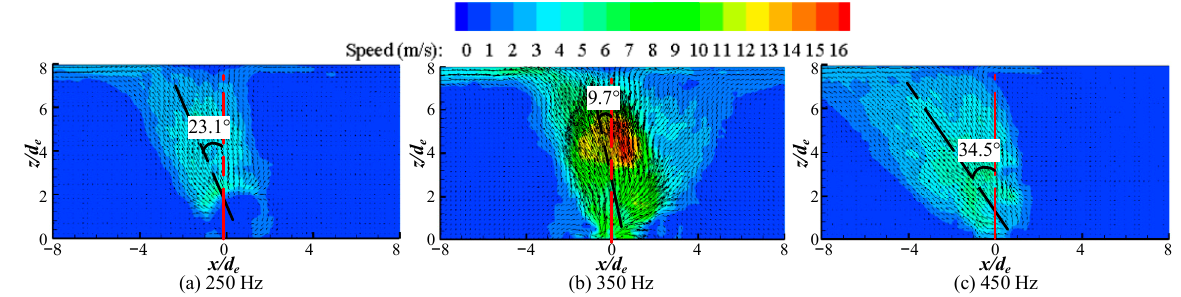
Figure 5. Velocity vector maps, contours and vectoring angles at different driving frequencies. Nu contours on the impinged surface at different driving frequencies and slider